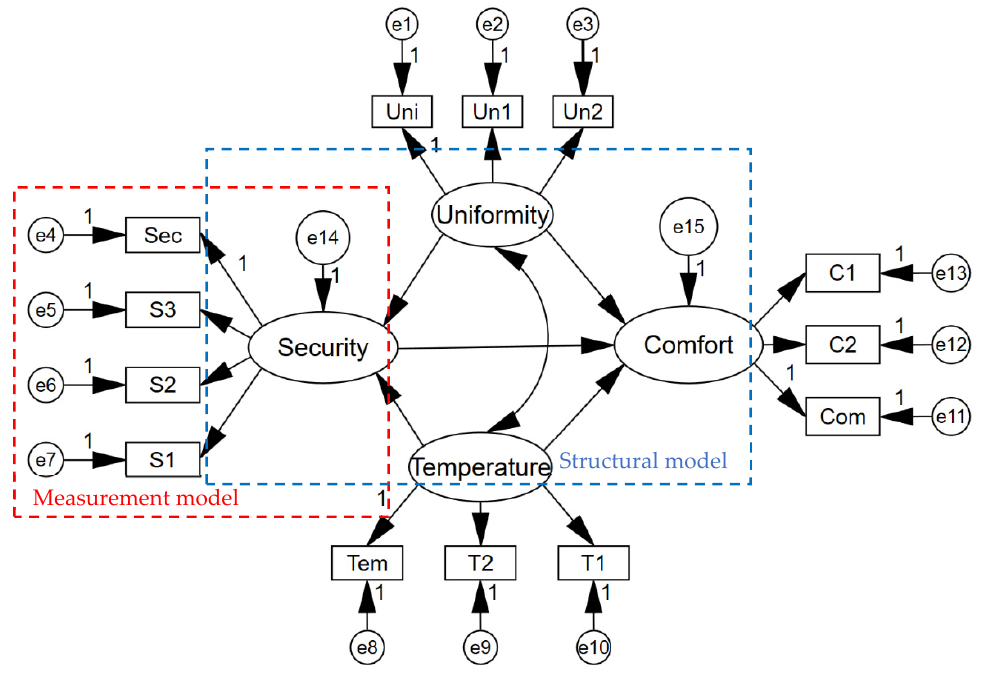
Figure 12. This research uses prior knowledge to assume a structural equation model.